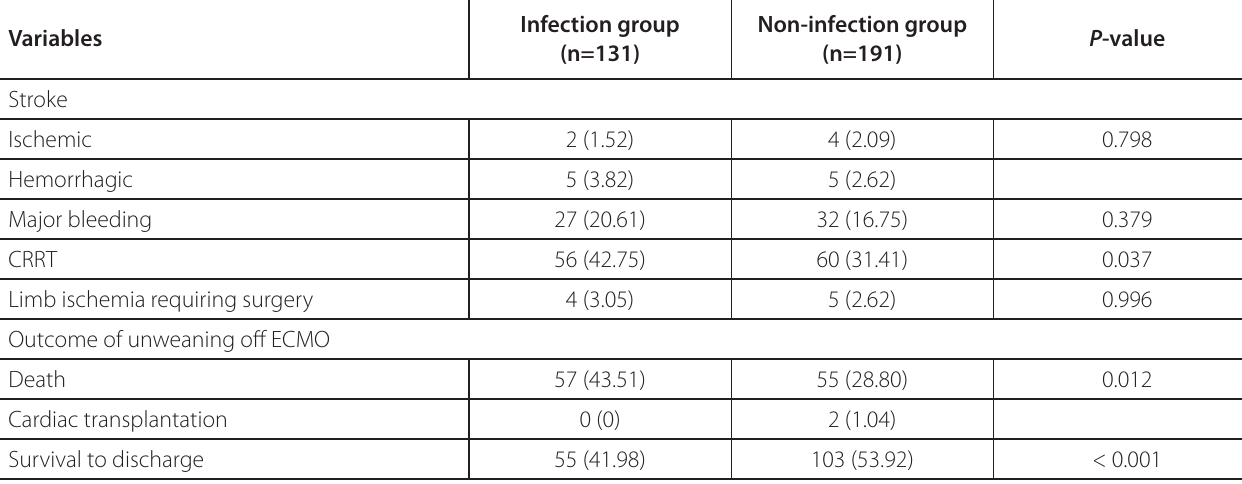
Table 3 . Patients’ major complications and in-hospital outcomes.